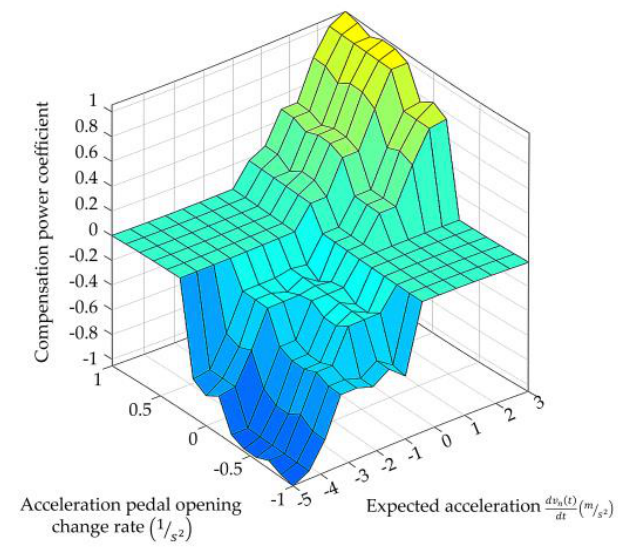
Figure 9. The transfer function. Table 1. The fuzzy rule description.